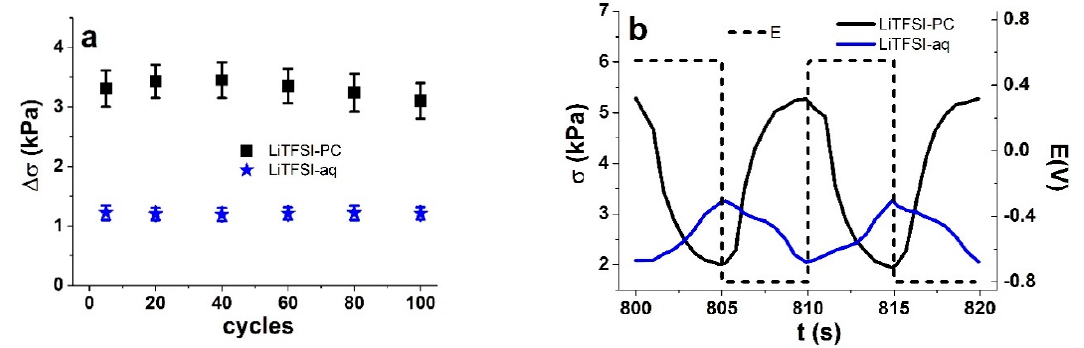
Figure 5. Long-term measurements of square wave potential steps at 0.1 Hz of Cell-CNT fibers showing in ( a ) the stress difference Δσ against cycle number in LiTFSI-PC ( ■ ) and LiTFSI-aq ( ★ ). Cycles 80-81 of Cell-CNT fibers showing stress σ against time t and in ( b ) of LiTFSI-PC (black line) and LiTFSI-aq (blue line) electrolytes with applied potential E (dashed line) from 0.55V to − 0.8V. The stress differences of Cell-CNT fibers operated in LiTFSI-PC show a slight increase (from 3.3 kPa to 3.45 kPa) by cycle 40, to a decrease to 3.1 kPa by cycle 100 (Figure 5a). In